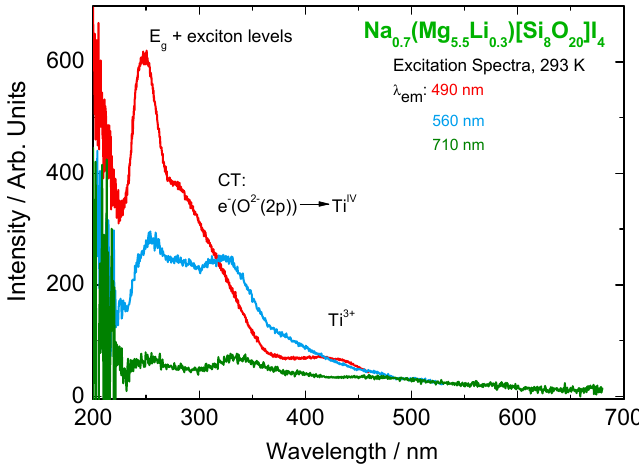
Figure A8. Excitation spectra of iodohectorite recorded at several emission wavelengths. The data are not corrected for the detector sensitivity at different emission wavelengths.